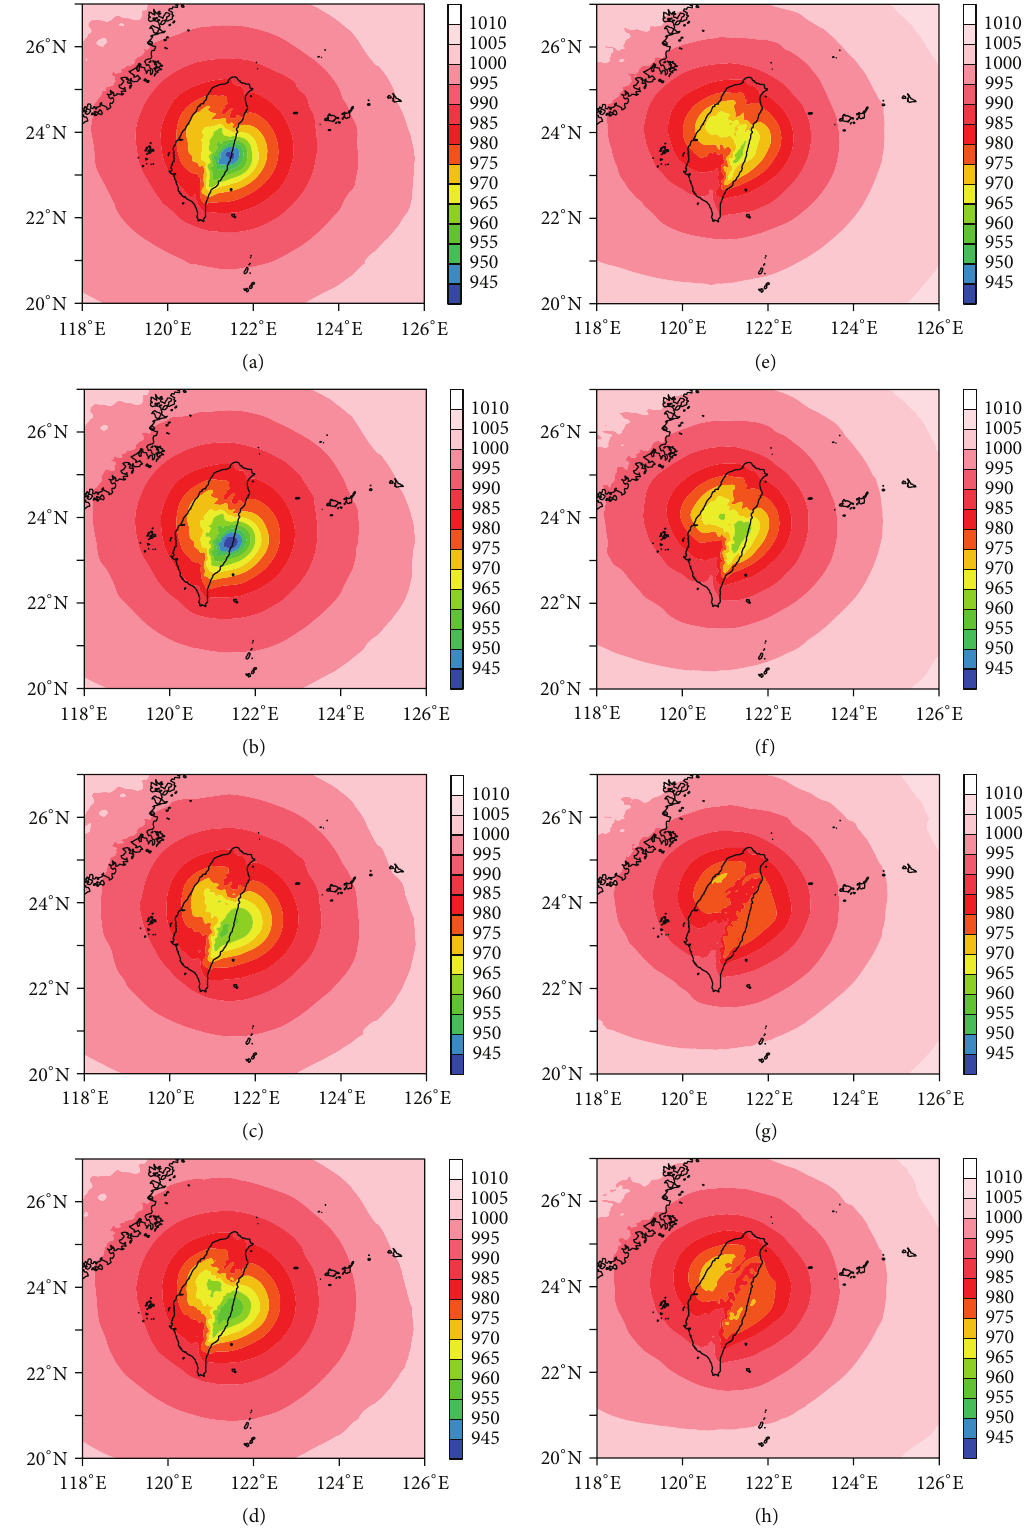
Figure 11: MSLP (units: hPa) of the modeled TC in (a) CTRL, (b) No hflux, (c) No qflux, and (d) No flux at 06 UTC 18 July 2005; (e) ∼ (h) are the same as (a) ∼ (d) but for 12 UTC 18 July